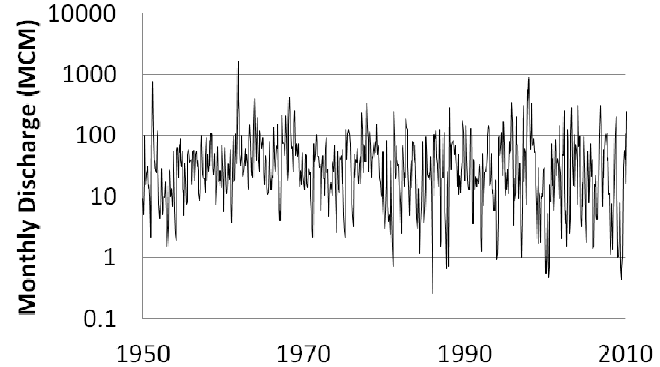
Figure 7. Variation in monthly discharge of the Ewaso Ng’iro at Archer’s Post